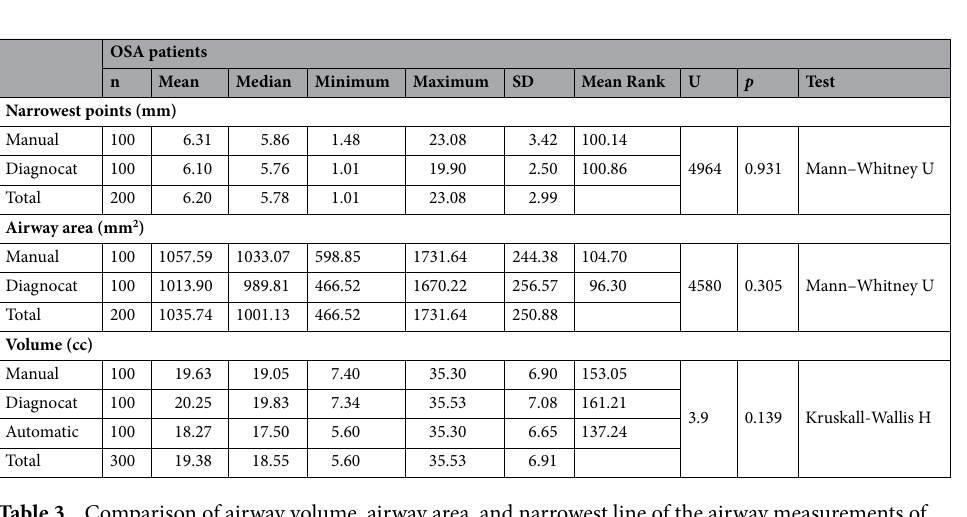
Table 3. Comparison of airway volume, airway area, and narrowest line of the airway measurements of Diagnocat, manual technique, and automatic technique in patients with